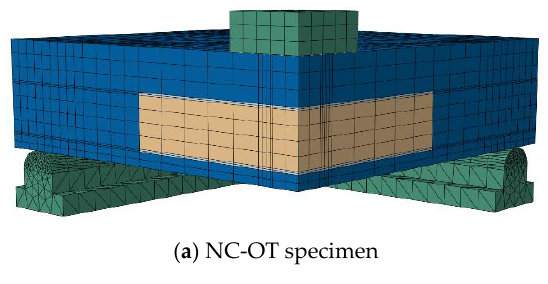
Figure 17. Model of NC-OT slab. Table 4. CDP parameters used for concretes, mechanical properties of steel bar meshes, and steel skeleton.